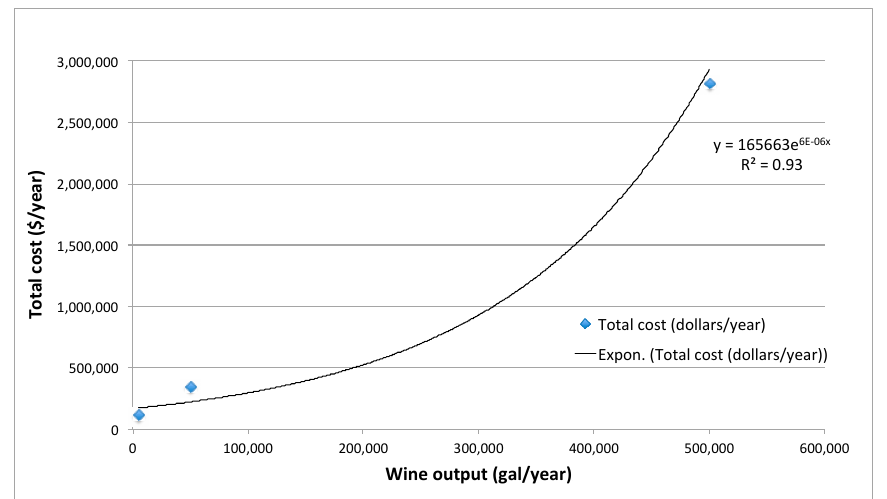
Figure 3. Total annual production costs according to scale of operation.